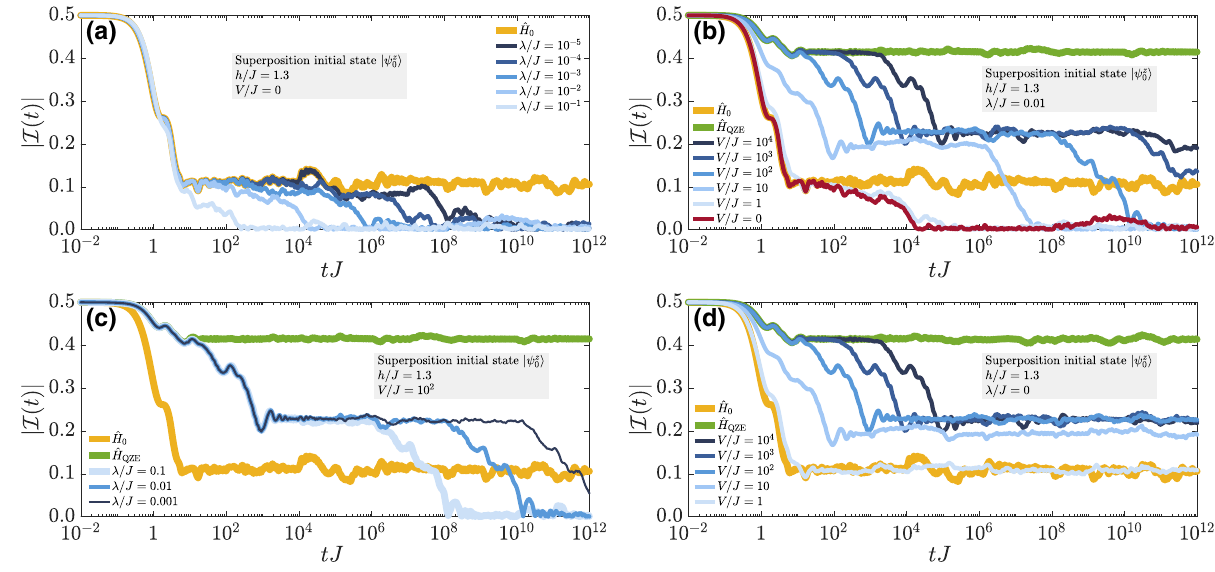
(cid:3) , a bosonic domain- 0 (cid:3) a superposition over 0 (cid:2) ˆ P ( ˆ H + λ ˆ H ) ˆ P 0 1 w w , with an enhanced local symme- w